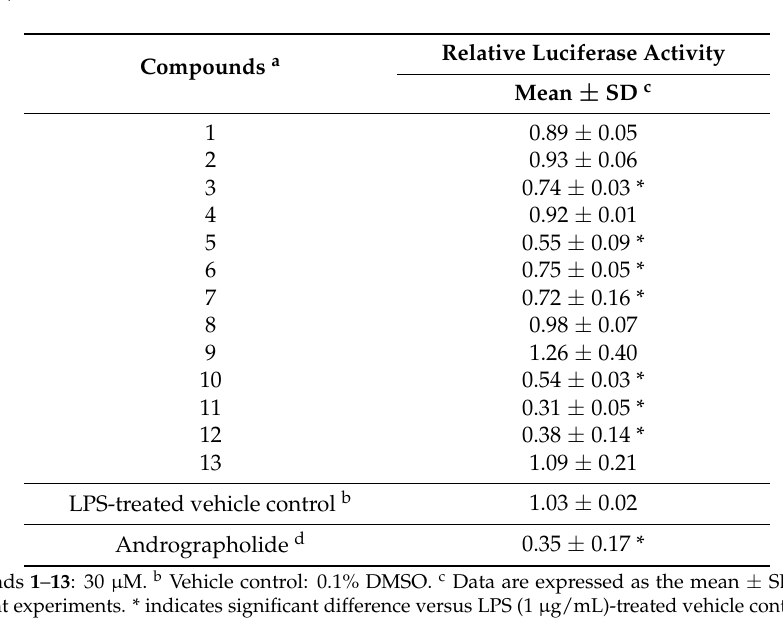
Table 1. The effects of compounds 1 – 13 from the resinous wood of A. sinensis on NF- κ B activation in RAW 264.7/Luc-P1 cells.